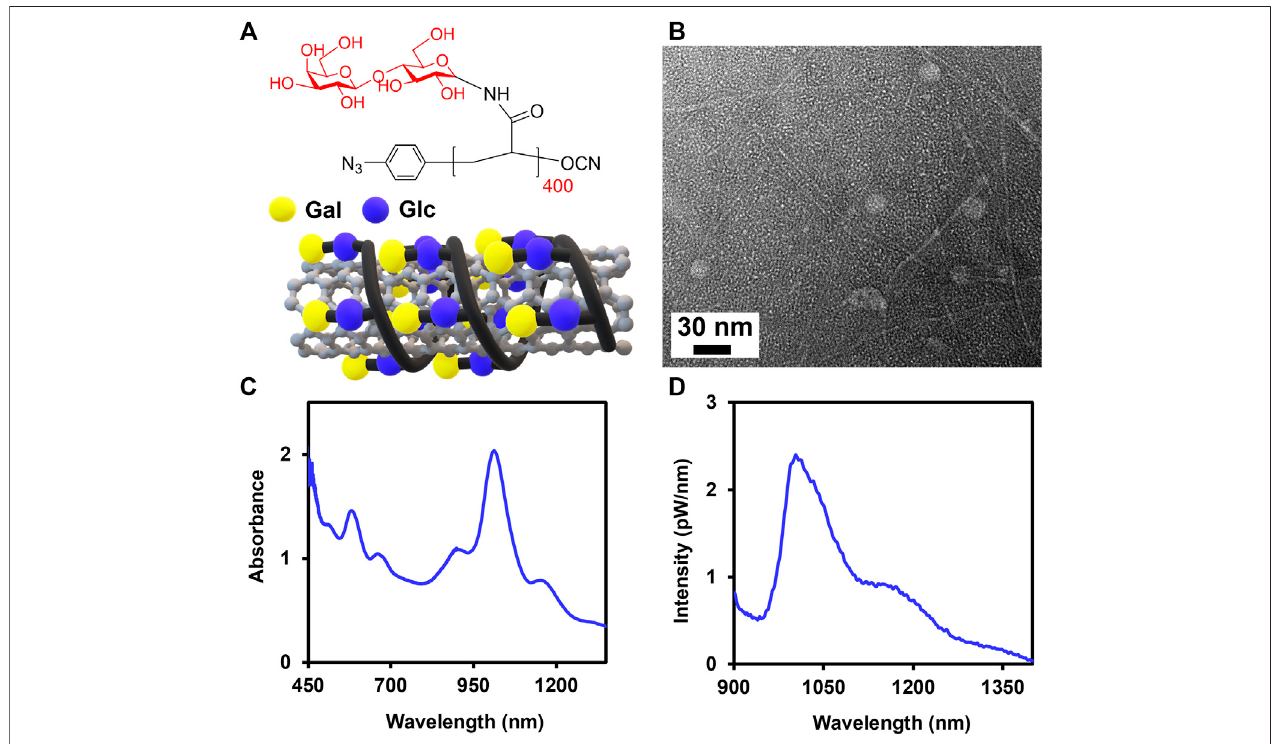
FIGURE1| NoncovalentcomplexationofSWCNTswithLact-homopolymer. (A) ChemicalstructureofLact-AM400homopolymerandtheschematicofaSWCNT wrapped by Lact-homopolymer. (B) TEM of Glyco-SWCNT sample containing excess, unbound Lact-homopolymer. Representative (C) absorbance and (D) NIR fl uorescence spectraofsupernatant samples of0.1 mg/ml SWCNTs dispersed inan aqueous solutionof0.4 mg/ml Lact-AM400. Nanotube sampleswere diluted by a factor of 2× in DI water for optical characterization.